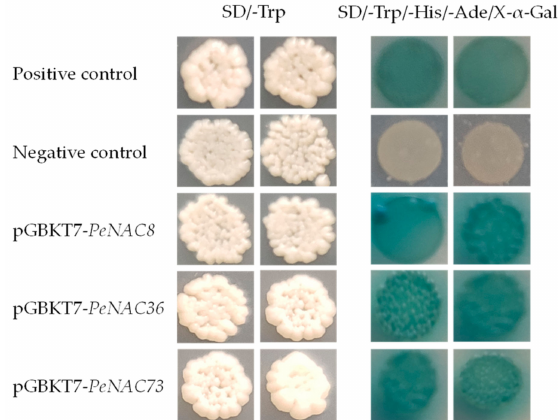
Figure 11. Assay of PeNAC s transcriptional activation activity in yeast. The positive constructs, negative constructs, and PeNAC s fused constructs were transformed into AH109 strains respectively, and successively incubated in SD / -Trp media and SD / -Trp / -His / -Ade supplemented with X- α